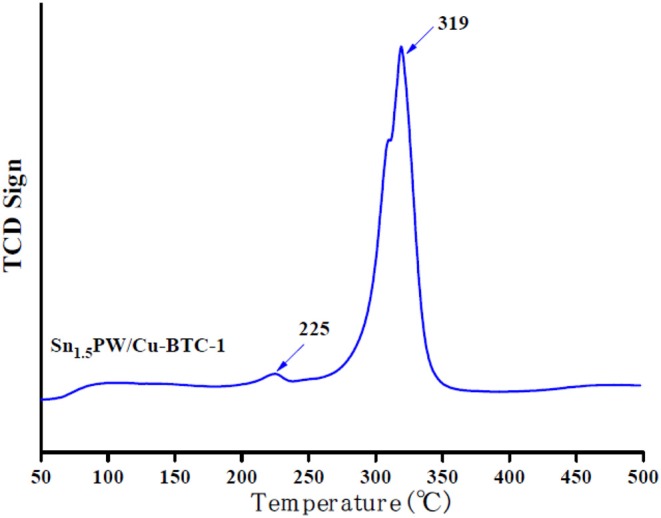
NH3-TPD patterns of Sn1.5PW/Cu-BTC-1 nanocomposite.